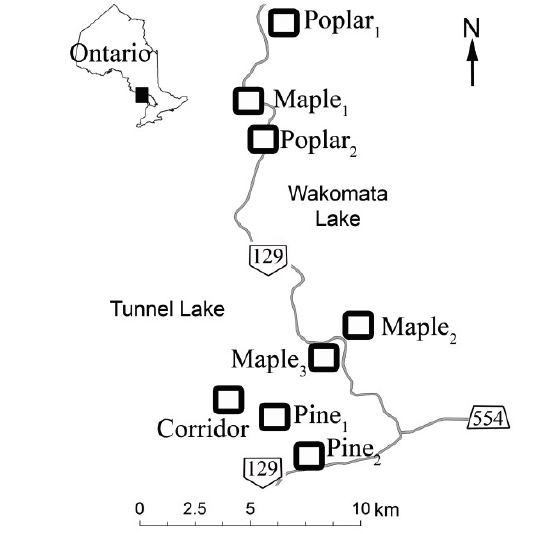
Figure 1. Map of the study area and the locations of the eight field survey sites.